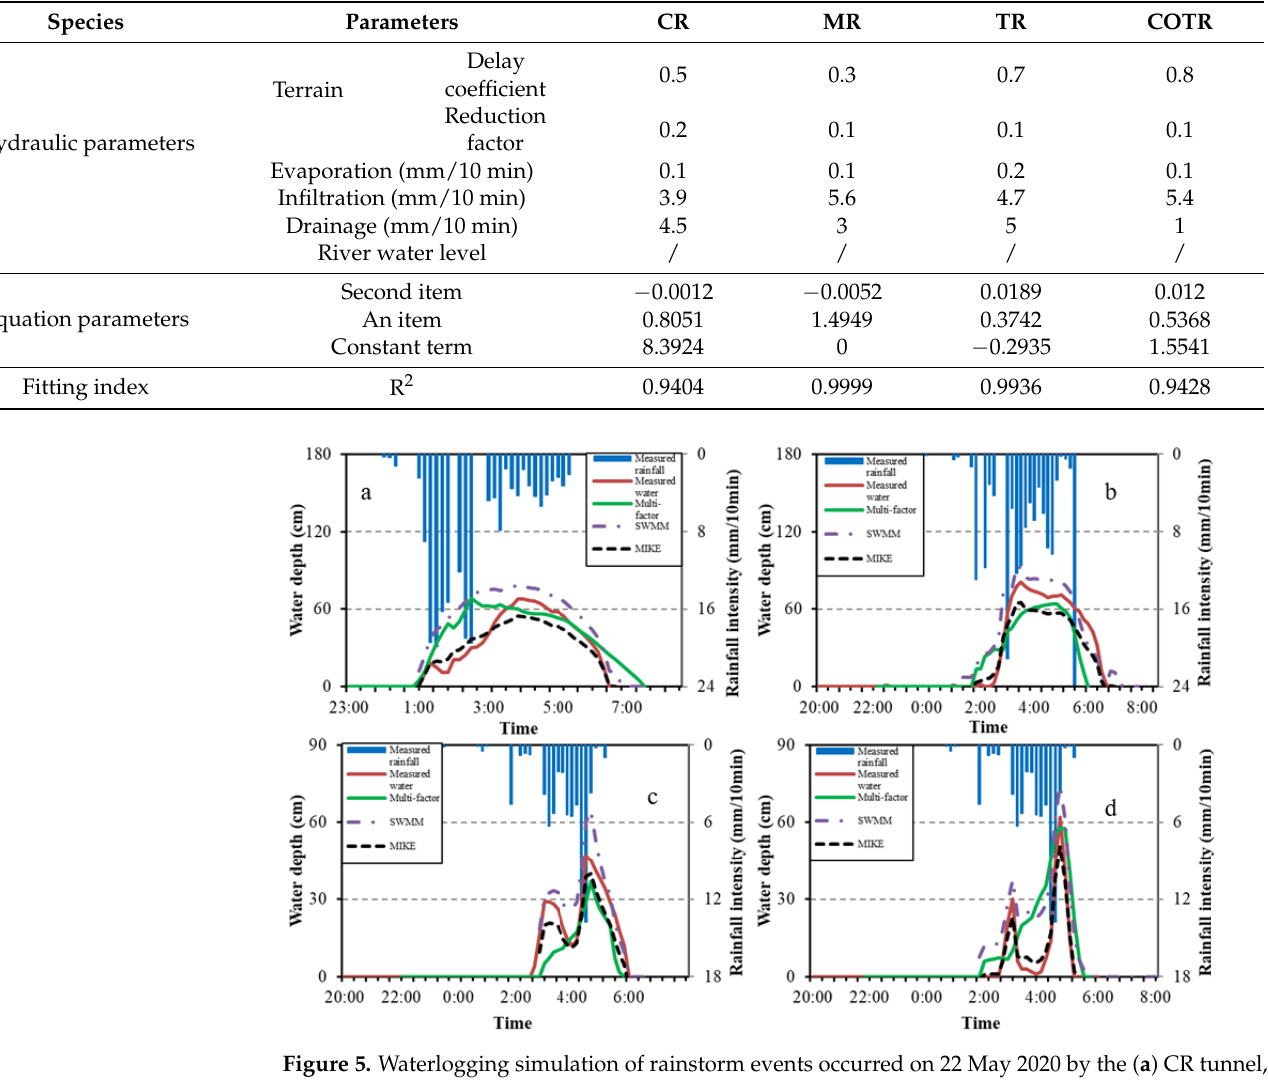
Figure 5. Waterlogging simulation of rainstorm events occurred on 22 May 2020 by the ( a ) CR tunnel, ( b ) MR tunnel, ( c ) TR tunnel, and ( d ) COTR tunnel. Based on the data presented in Table 6, we found that the error of the multi-factor correlation model (erro r = −1 3%) was the least for the simulation of the maximum water volume, followed by the Mike Urban model (erro r = −1 9%), and finally the SWMM model (error = 20%). There is little difference in the errors of the three models. Better prediction results can be obtained by using the ensemble forecast of multiple models in practice. Table 6. Table of waterlogging simulation results of rainstorm events with each model on 22 May 2020 by the (a) CR tunnel, (b) MR tunnel, (c) TR tunnel, and (d) COTR tunnel. Total Rainfall Flooding Point (mm)